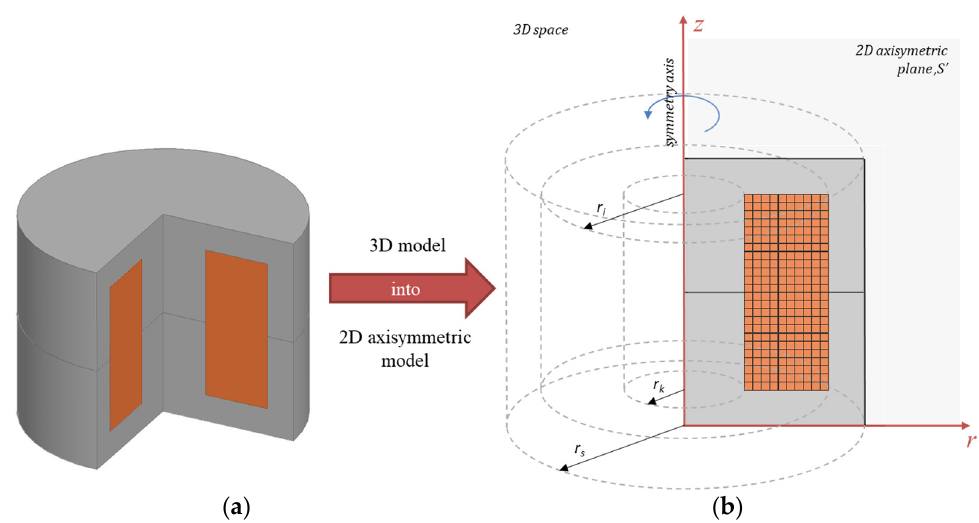
Figure 1. 3D view of a considered inductor ( a ) and its representation in a 2D axial symmetry system ( b ).